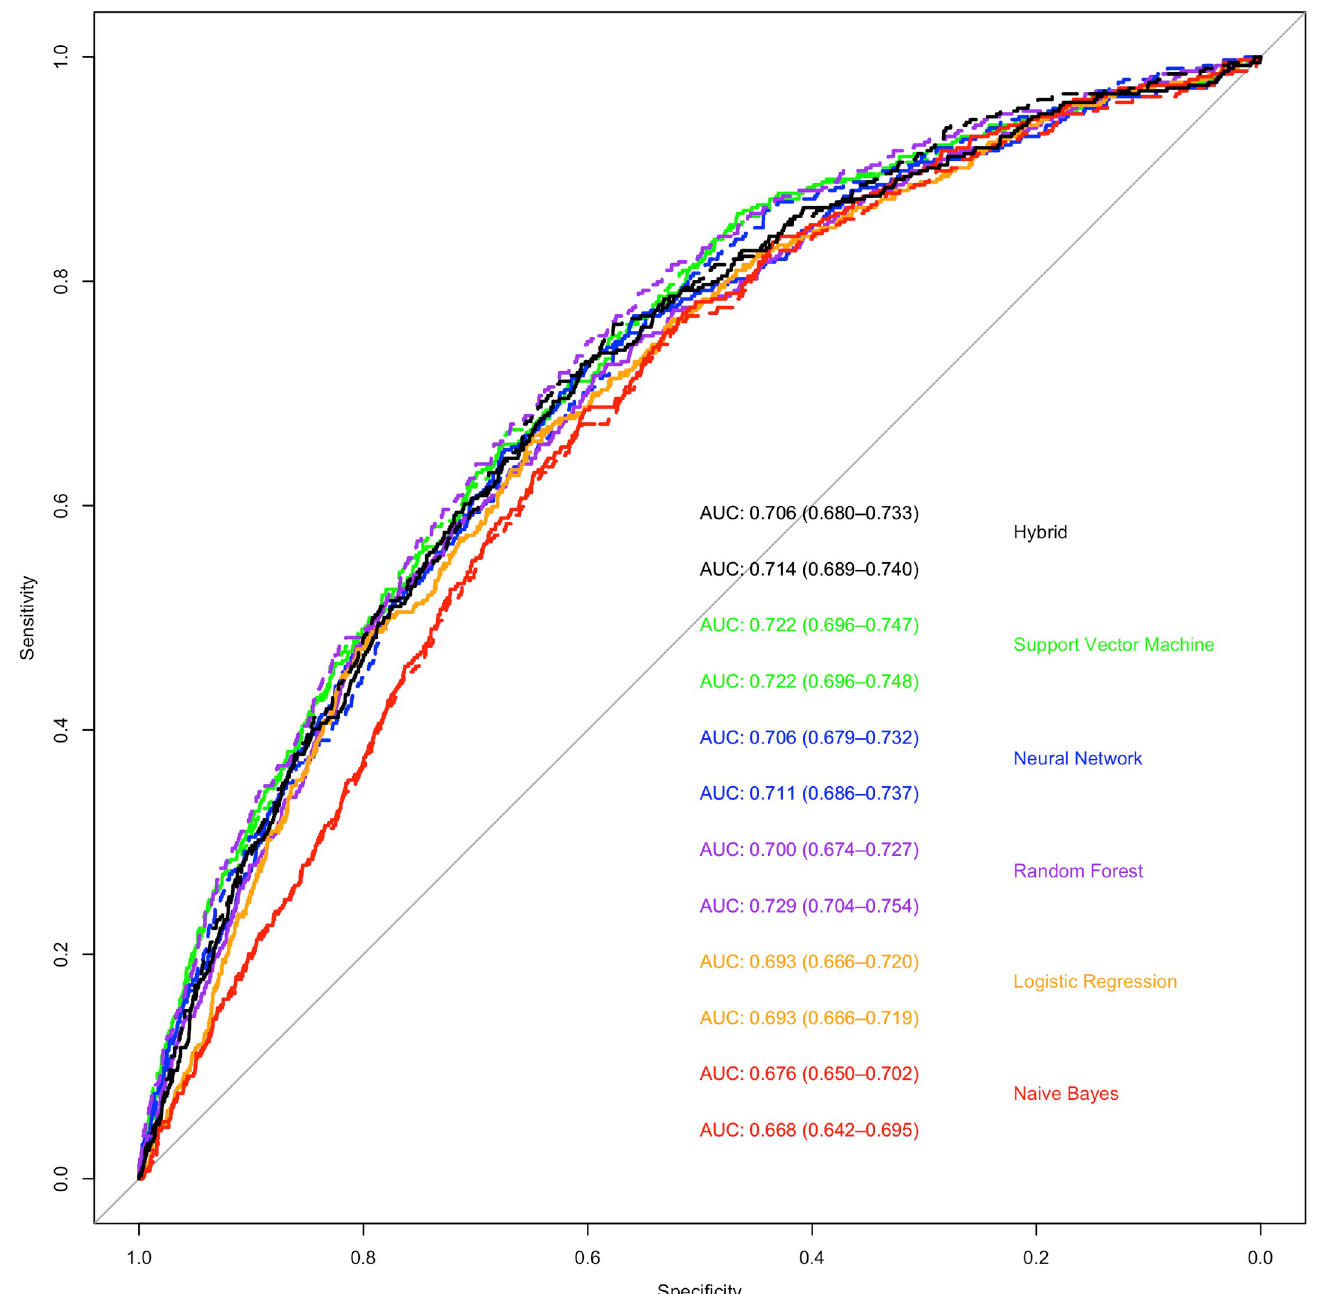
Fig 4. Receiver operating curves that demonstrate the ability of various machine learning methods to classify rapid and non-rapid progressors based on the results of the first or first two visual fields. The colors represent the following machine learning methods; Green- support vector machine; Blue- artificial neural network; Purple- random forest; Orange—logistic regression; Red—na ï ve Bayes. Black–Hybrid model. The solid lines represent models trained on data from the first VF alone and the dashed line represents models trained on data from the first and second VF. The area under the curve and 95% CI are shown on the bottom right (the top number of each color is model trained on first VF while the bottom number is models trained on first two VFs). https://doi.org/10.1371/journal.pone.0249856.g004 In a multivariable logistic regression model, older age, more negative MD, higher PSD and higher false positive and false negative VF testing response rates were significantly associated with a higher odds of rapid progression, each with modest effect sizes ( Table 4 ). Plots of